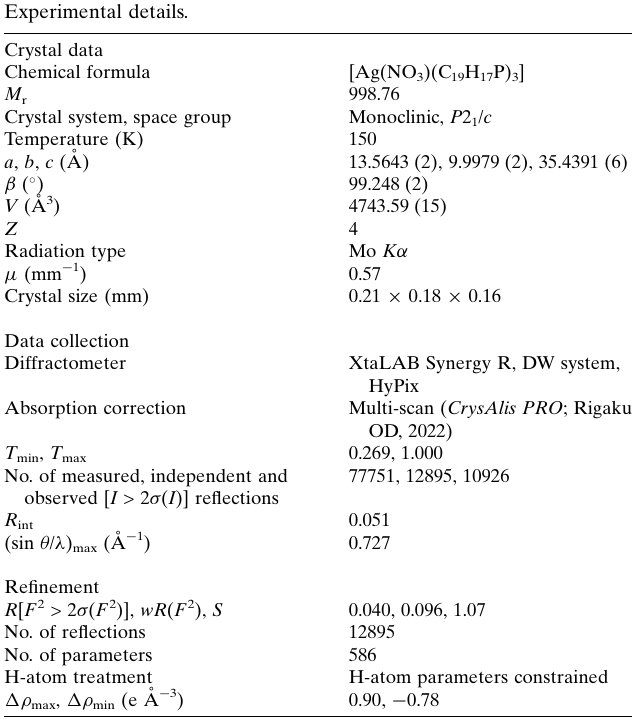
Table 2 Experimental details.